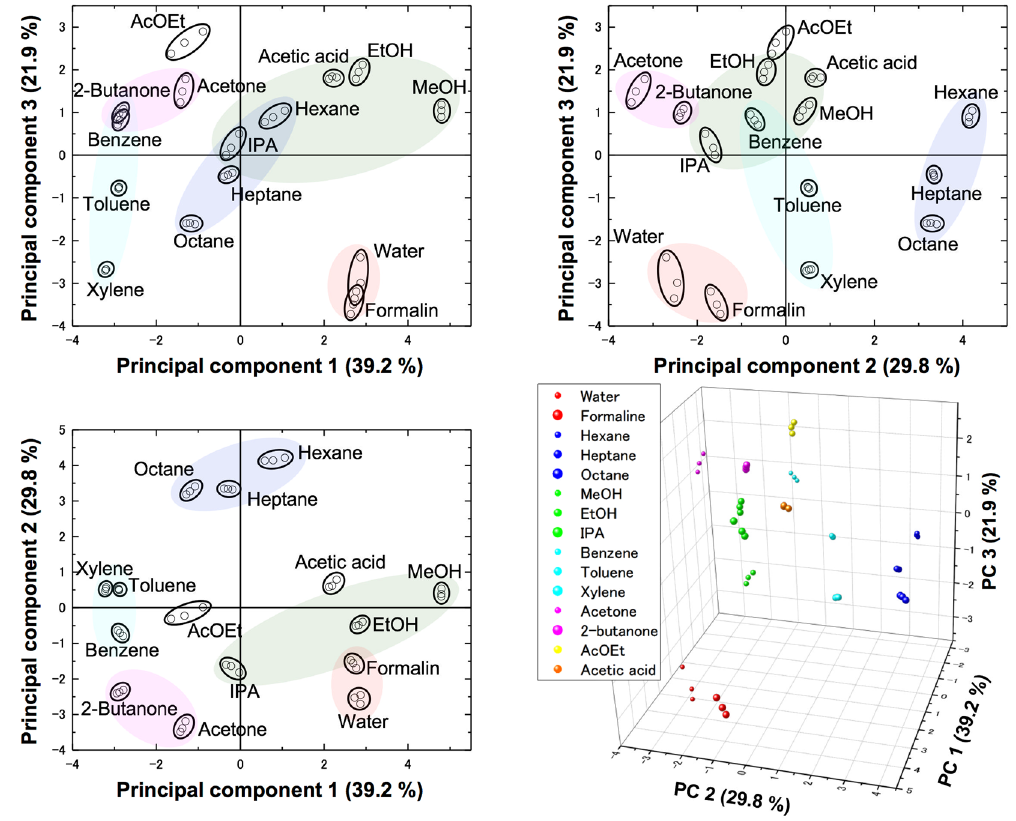
Figure 5. PCA plots to discriminate the 15 chemicals using the NPs-coated MSS. (Top left, top right, and bottom left) The 2D plot with the two principal components. (Bottom right) The 3D plot drawn based on the three principal components. The PCA shown here was performed utilizing four parameters extracted from the last three measured responses shown in Figure S2. The details on the extraction procedure are explained